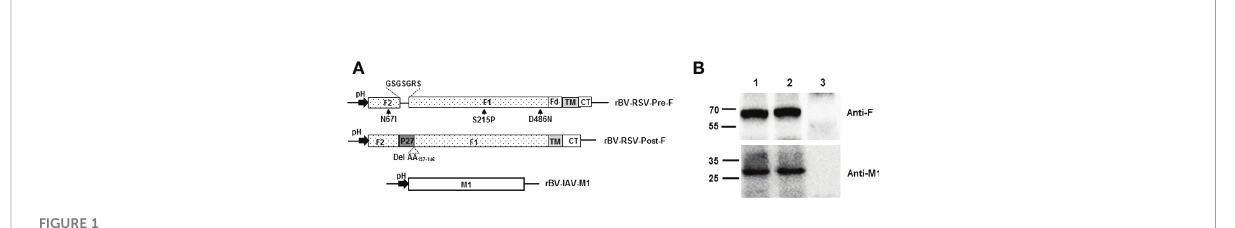
FIGURE 1 Construction of recombinant baculoviruses and expression of proteins in Sf9. (A) Schematic representation of the recombinant baculovirus vectors used in the present study. pH, polyhedrin promoter of baculovirus; (B) Coexpression of the RSV F and H1N1 M1 proteins in Sf9 cells. Sf9 cells were infected with the indicated rBVs, harvested at 3 days postinfection (p.i.) and subjected to Western blot analysis using a mouse monoclonal anti-RSV F antibody and a mouse polyclonal anti-H1N1 M1 antibody. M, Molecular marker; Lane 1, rBV-RSV-Pre-F/M1; Lane 2, rBV- RSV-Post-F/M1; Lane 3, Sf9